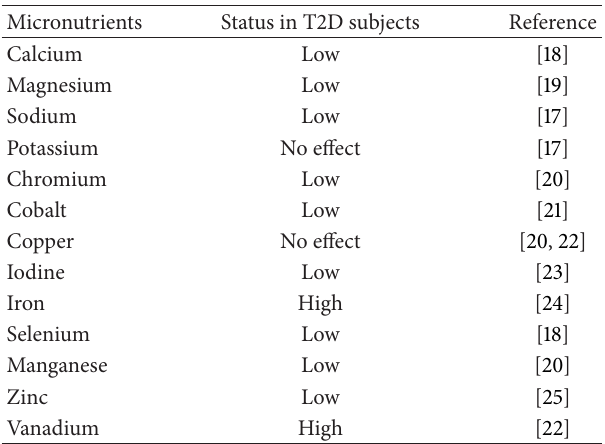
Table 1: Micronutrient status in Type 2 diabetes